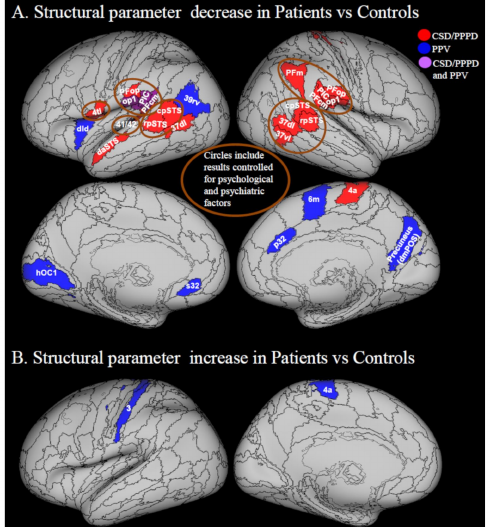
Figure 2. Structural parameters in Patients vs. Controls. Regions from PPPD are in red, regions from PPV are in blue and regions in common are in purple. ( A ) Parameter reduction. Wurthmann et al. [51] found reduced grey matter in patients with PPPD compared to healthy controls in the superior temporal sulcus (STS), left dorsal anterior (daSTS = BA 22r) and left rostral posterior (rpSTS) regions, left middle temporal gyrus in the dorso-lateral Brodmann area (BA) 37 (37 dl), and right primary motor cortex in BA 4 a. Popp et al. [48] found grey matter decrease in the left rostroventral BA 40 (PIC) and left PFcm within the supramarginal gyrus, left parietal operculum OP1 and right medial premotor cortex BA 6 (6m). They also found reduced cortical thickness in the left middle insula (dorsal dysgranular insula = dId), left inferior parietal cortex in the rostro-ventral BA 39 (39rv), left primary visual cortex (hOC1), left ventromedial prefrontal cortex in the subgenual BA 32 (s32), right anterior cingulate cortex in the pregenual BA32 (32p), and in the right precuneus in the dorso-medial parietal occipital sulcus (dmPOS). Nigro et al. [46] found reduced cortical folding in left superior temporal gyrus (BA 41/42), bilateral rostral and caudal posterior superior temporal sulcus (rpSTS, cpSTS), left BA 4 larynx and tongue region (4tl), bilateral suprarmarginal gyrus and adjacent parietal operculum (Pfop, PFcm, PIC, op1), right PFm and right ventro-lateral BA 37 (37 vl, 37dl). Circled areas come from this last analysis and are controlled for psychological and psychiatric